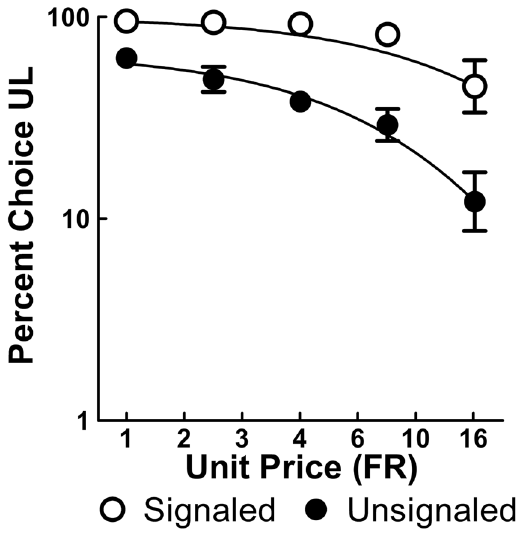
Figure 7. Mean ( ± SEM) percent choice of the UL alternative as a function of its response requirement fit with Equation 2 ( n =